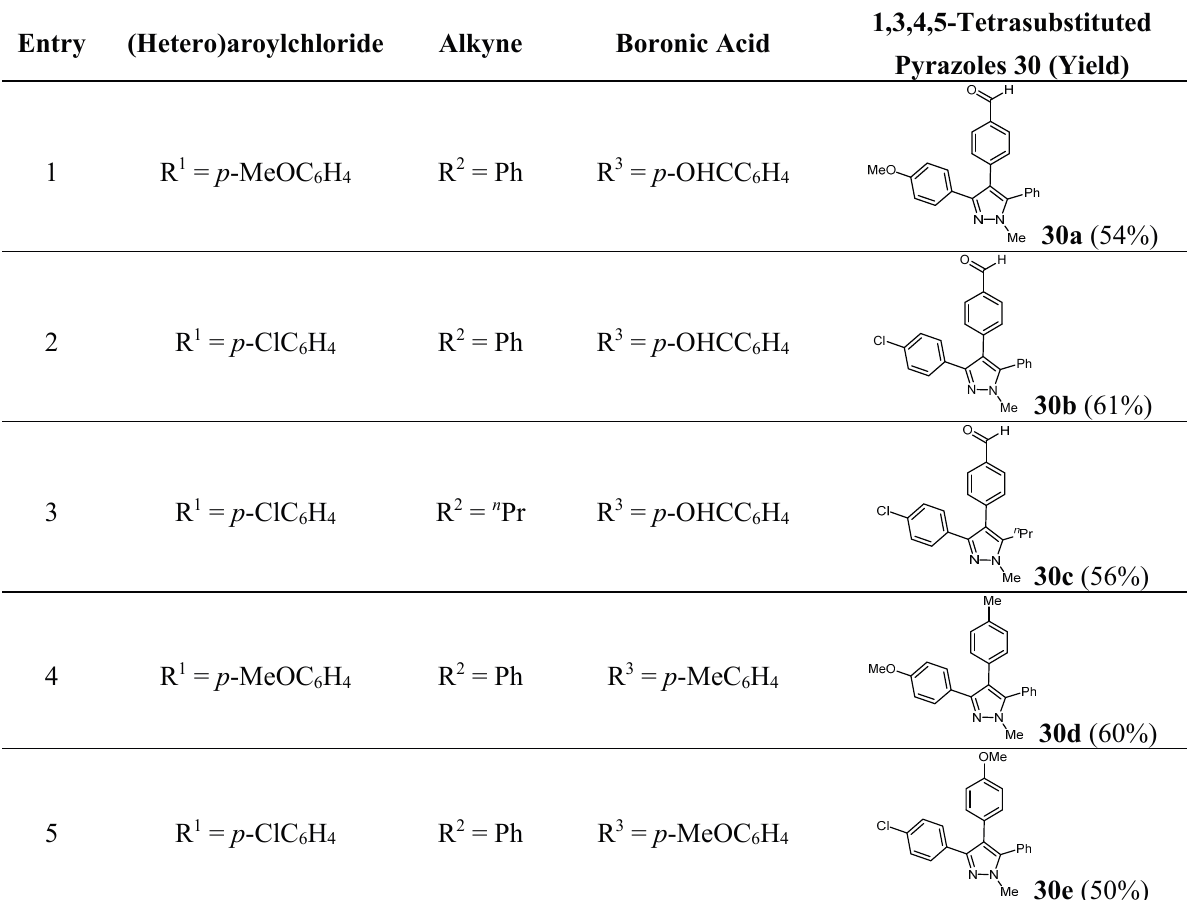
Table 10. Selected 1,3,4,5-tetrasubstituted pyrazoles 30 via sequentially